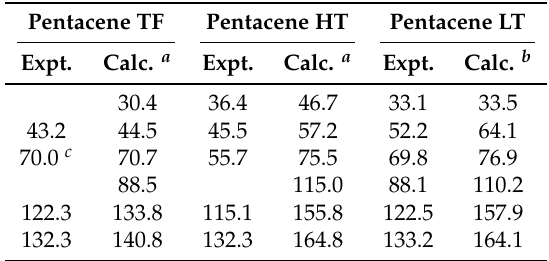
Table 2. Room temperature experimental frequencies (cm − 1 ) of the three pentacene polymorphs, compared with the k = 0 frequencies calculated in the rigid molecule approximation at potential energy